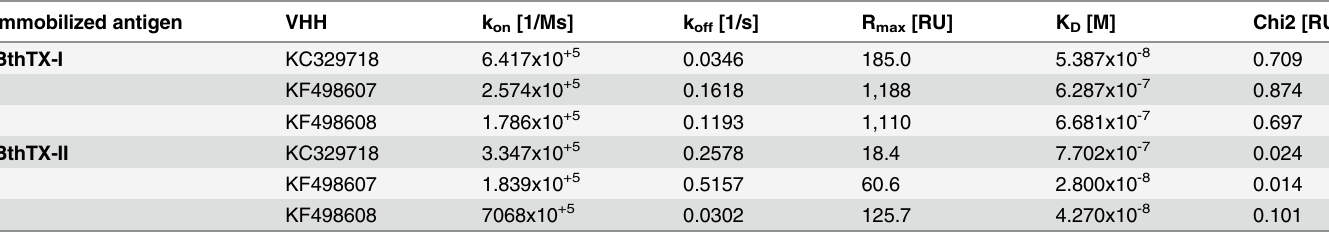
Table 2. Interaction analysis by SPR. Immobilized antigen VHH k on [1/Ms] k off [1/s] R max [RU] K D [M] Chi2 [RU]